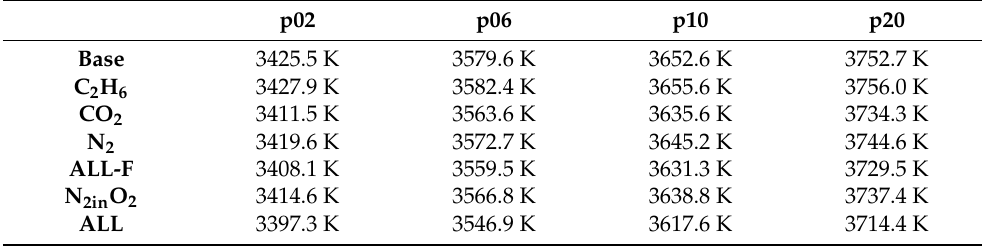
Table 6. Maximum flame temperature at stoichiometric mixture fraction for different impurities of the fuel and/or the oxidizer at different pressures (counter flow diffusion